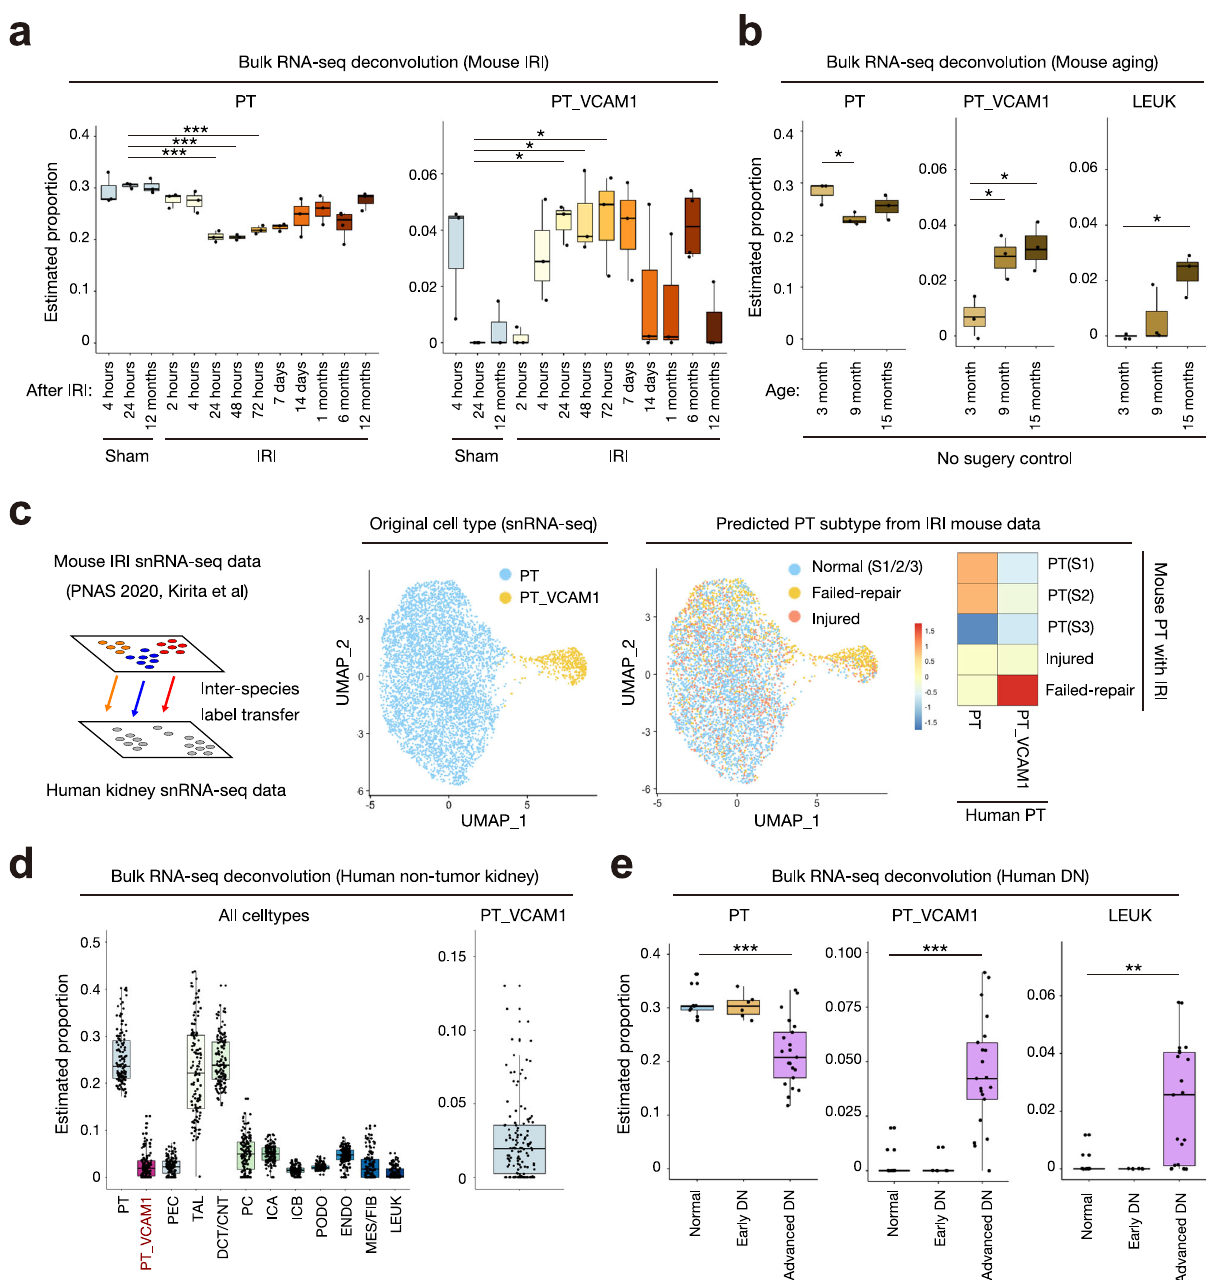
Fig. 7 The estimated proportion of VCAM1 + proximal tubular cells increases in acute and chronic kidney disease. a , b Deconvolution analysis of bulk RNA-seq mouse kidney IRI dataset (GSE98622) with BisqueRNA. Sham control and IRI ( a ), or no surgery control ( b ). c Inter-species data integration was performed between mouse IRI snRNA-seq (GSE139107) and human snRNA-seq with Seurat (left). PT and PT_VCAM1 from human snRNA-seq (middle) are label-transferred from mouse IRI snRNA-seq, and the frequencies of predicted cell types are shown on the heatmap (right). d Deconvolution analysis of bulk RNA-seq TCGA non-tumor kidney data ( e ) Deconvolution analysis of bulk RNA-seq human diabetic nephropathy (DN) data (GSE142025) with BisqueRNA. Box-and-whisker plots depict the median, quartiles and range. * P < 0.05; ** P < 0.01; *** P < 0.005, one-way ANOVA with post hoc Dunnett ’ s multiple comparisons test. All P values are provided in the Data Source fi